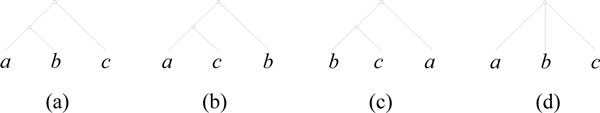
Triplet topologies. The four different triplet toplogies.